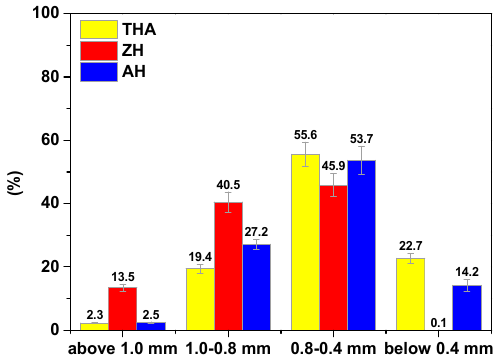
Figure 6. Grain size of THA, ZH and ZH. Additionally, the FTIR-ATR spectra of all of the hydrogels were measured before and after the adsorption process of Cu(II), Zn(II), Mn(II) and Fe(III) complexes with EDDS. In Figure 7, the characteristic AH bands, i.e., the stretching vibrations of the -CH 2 group at 1456 cm − 1 and the symmetric and asymmetric stretching vibrations of the carboxylate group at 1406 and 1551 cm − 1 , are presented. 4000 3500 3000 2500 2000 1500 1000 500 0.00 0.050.100.150.20 0.250.30